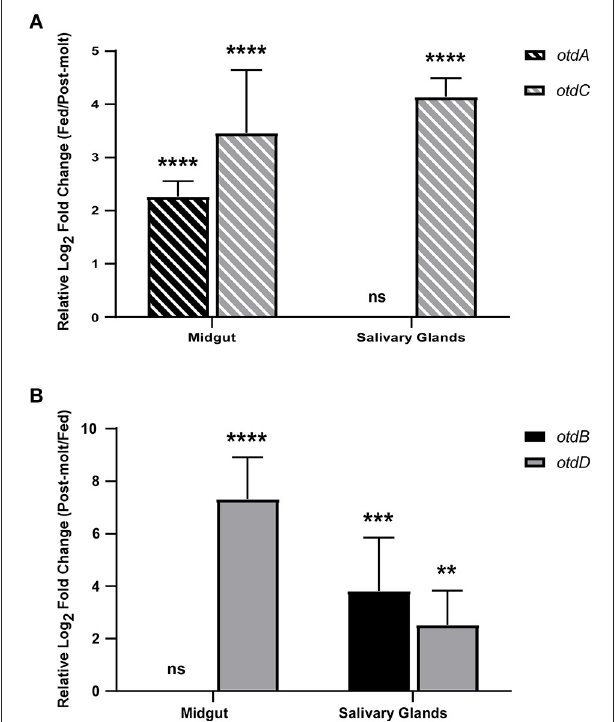
FIGURE 4 | Expression analysis of putative O. turicata defensins in post-molt and fed midguts and salivary glands. Putative O. turicata defensins (A,B) expression was assessed in the fed and post-molt midguts and salivary glands. Defensin expression was normalized to β -actin expression and the relative log 2 fold change was calculated using the 2 − 1 Ct method with post-molt (A) or fed (B) tissues as the control. Statistical significance was calculated between post-molt and fed tissue using the Student’s t -test with Welch’s correction. ( P -value: ** ≤ 0.01, *** ≤ 0.001, **** ≤